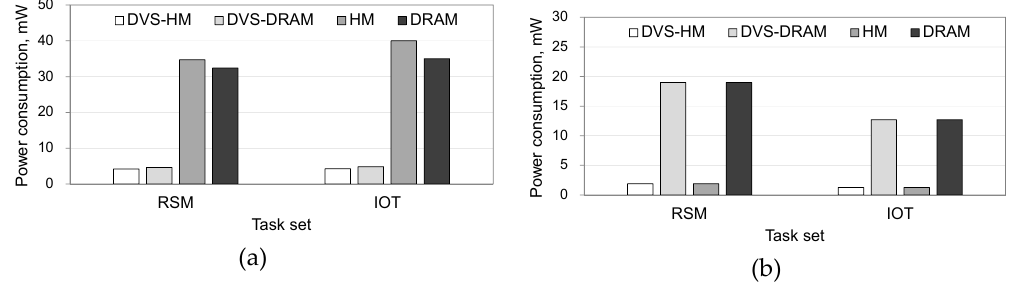
Figure 6. Processor and memory power consumptions under realistic workloads. ( a ) Power consumption in processor, ( b ) power consumption in memory.